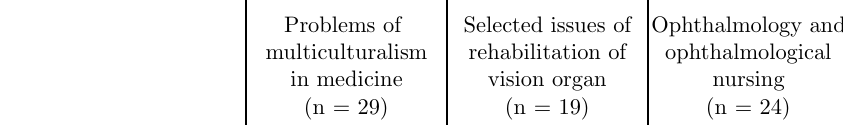
Table 2. Students’ satisfaction with e-learning classes for each subsequent course (n = 72; numbers of presented questions are related to questions in the survey ) Problems